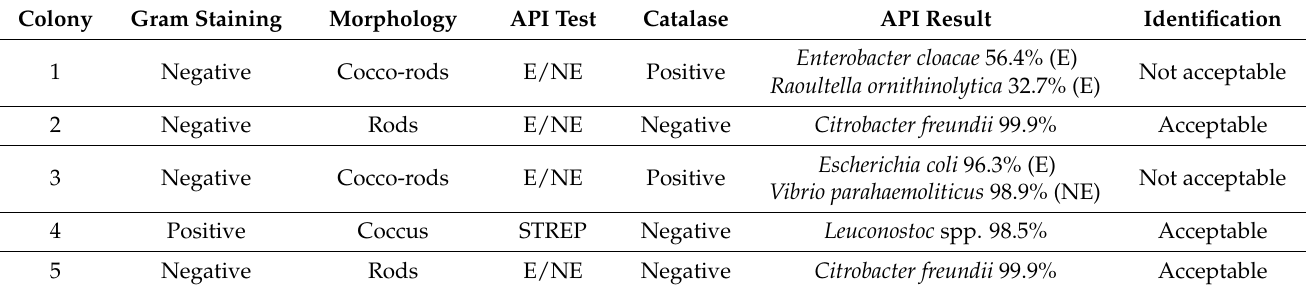
Table 2. Identification of the PHA-producing bacteria isolated in this study by Gram staining and API test. Colony Gram